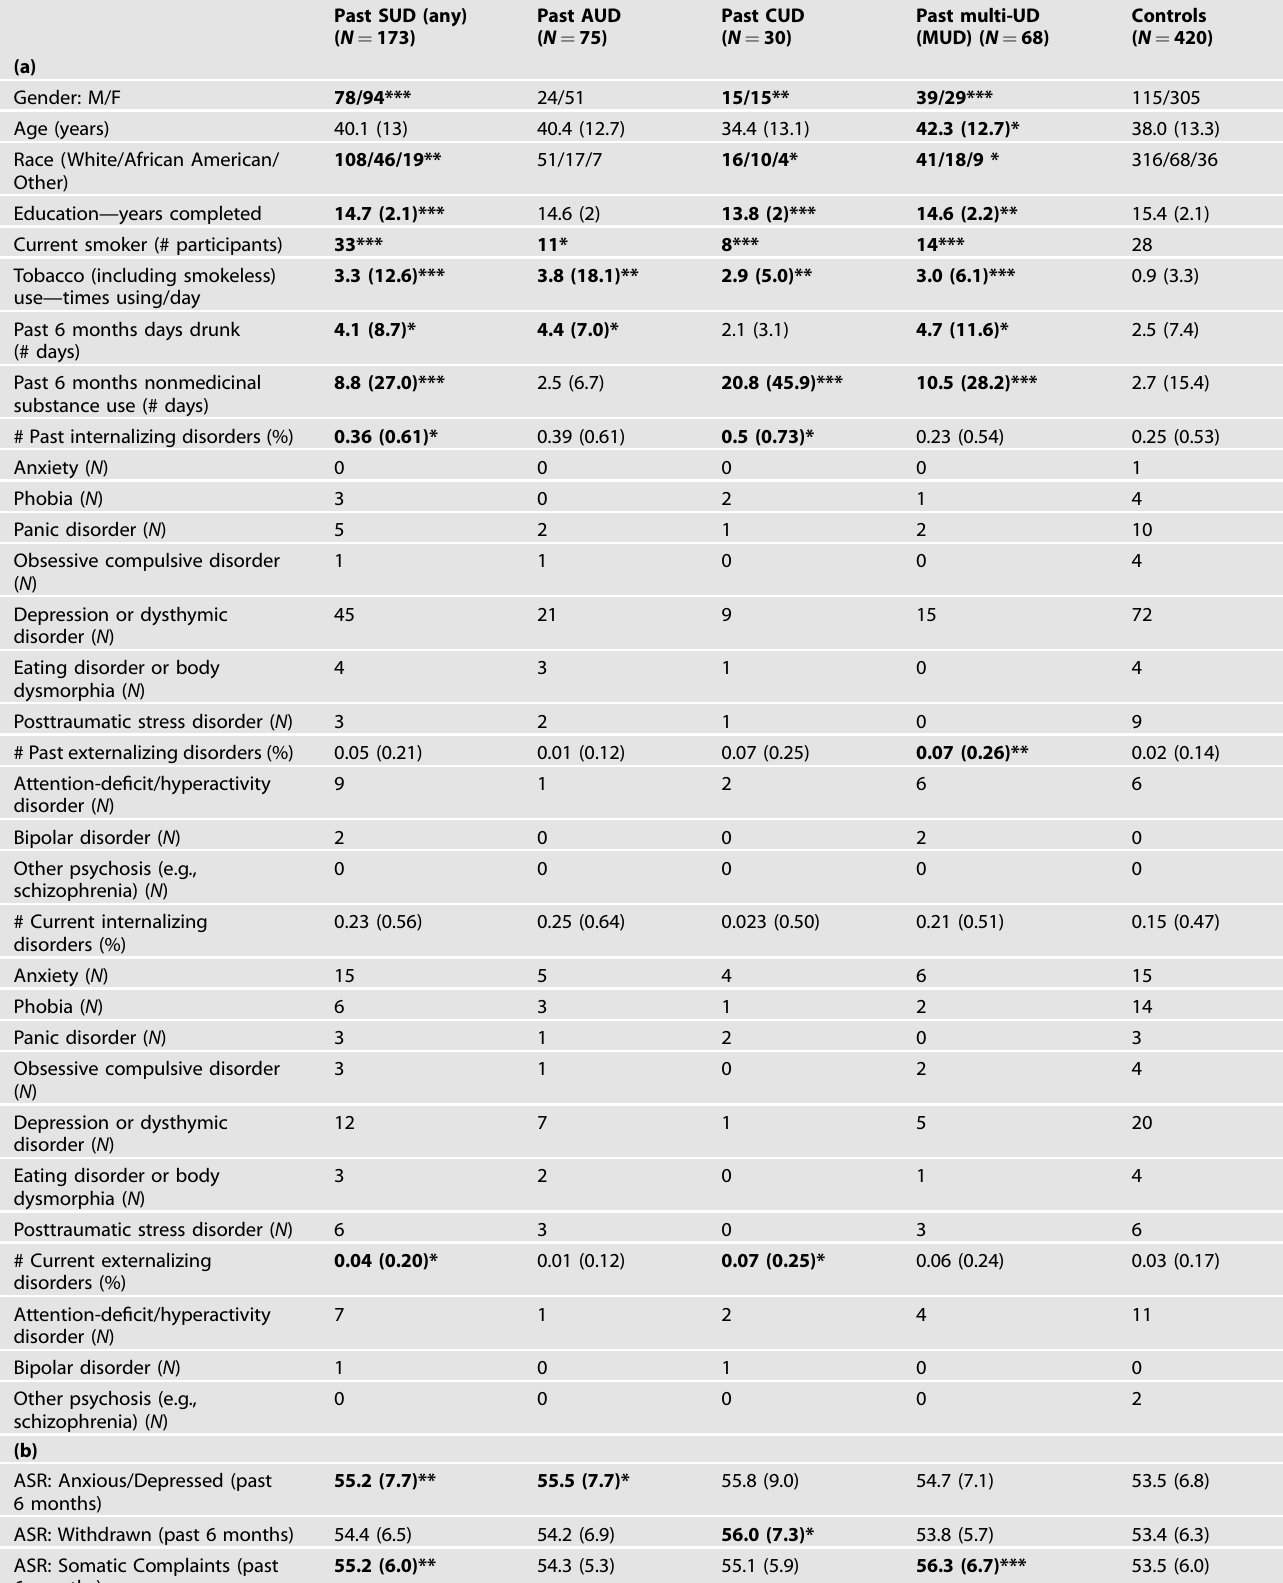
Table 1. (a) Demographics and diagnoses by past SUD; (b) clinical characteristics by past